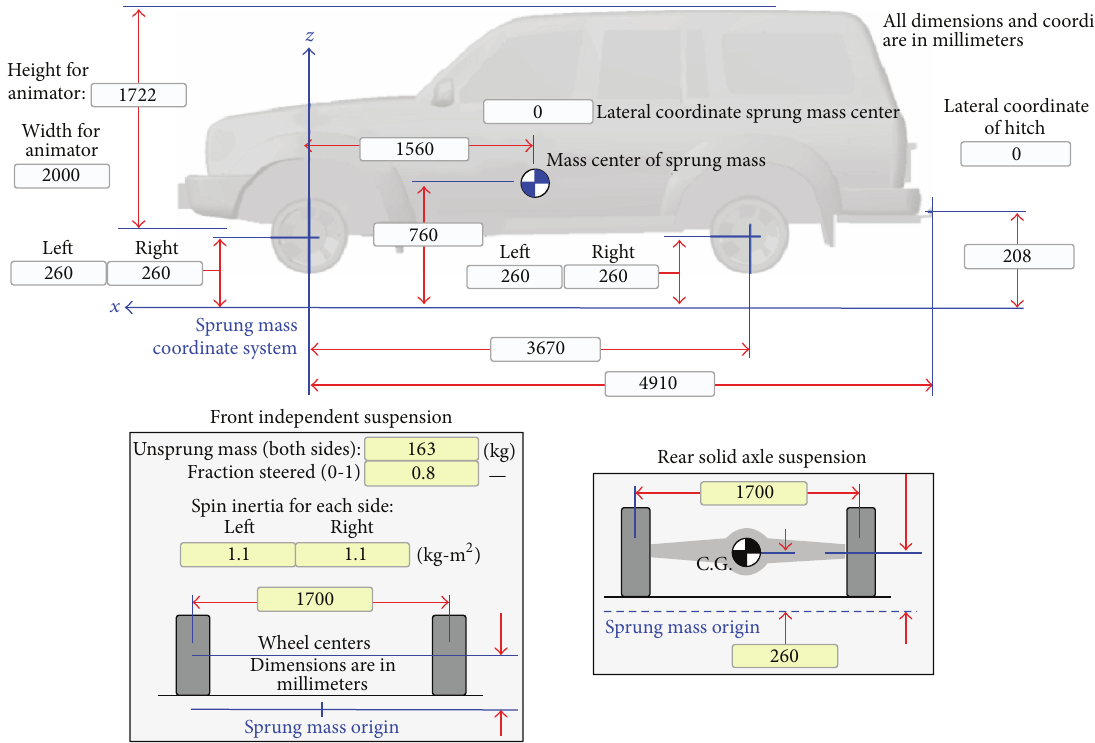
Figure 9: Parameters for the pickup vehicle model in CarSim .